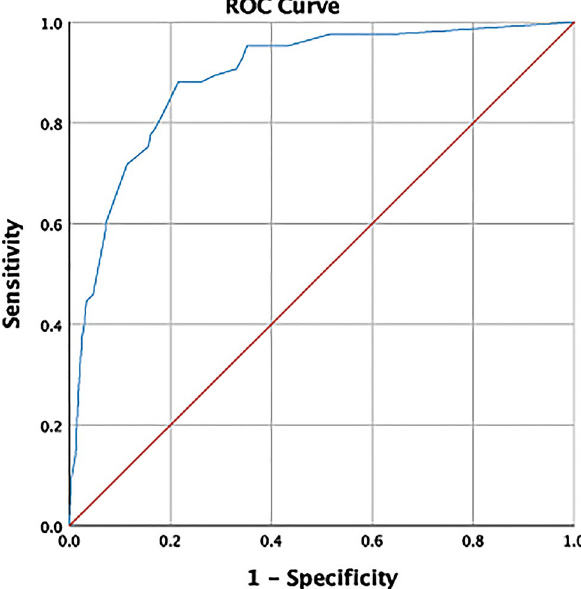
Figure 1. Discrimination power of the final multivariable model: ROC Curve plot. Discrimination power of the model (including Age ≥ 70 years, SpO 2 < 95%, neutrophils > 7.5 × 10 3 /µL, LDH ≥ 300 U/L, and CRP ≥ 100 mg/L) expressed by an area under the ROC Curve of 0.89 (95% CI 0.85–0.93), standard error of 0.02 (under the non- parametric assumption), and p < 0.001 (being the null hypothesis a true area =